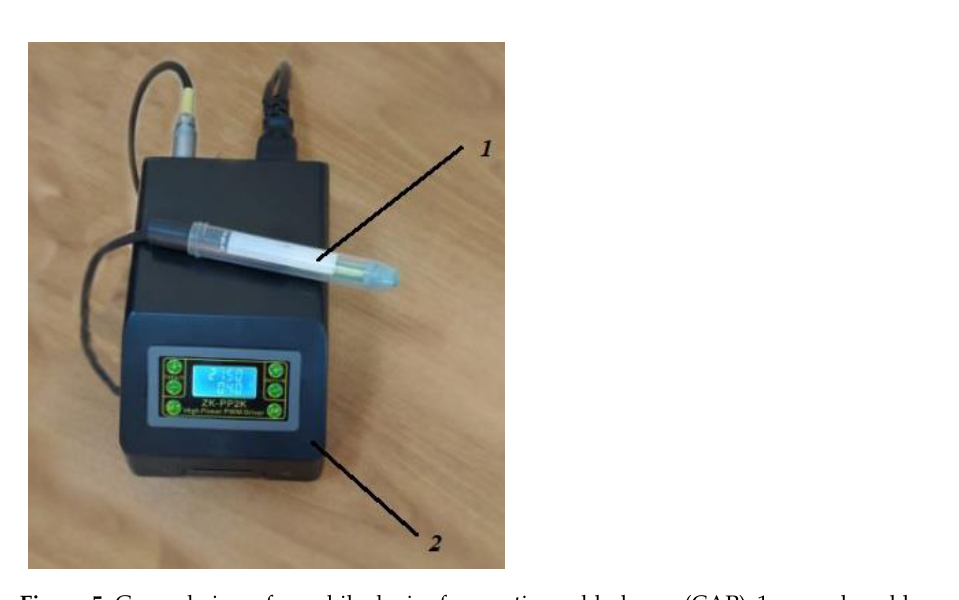
Figure 5. General view of a mobile device for creating cold plasma (CAP): 1 — a replaceable module on the surface of which CAP is created; 2 — hardware control block for DBD CAP creation modes.